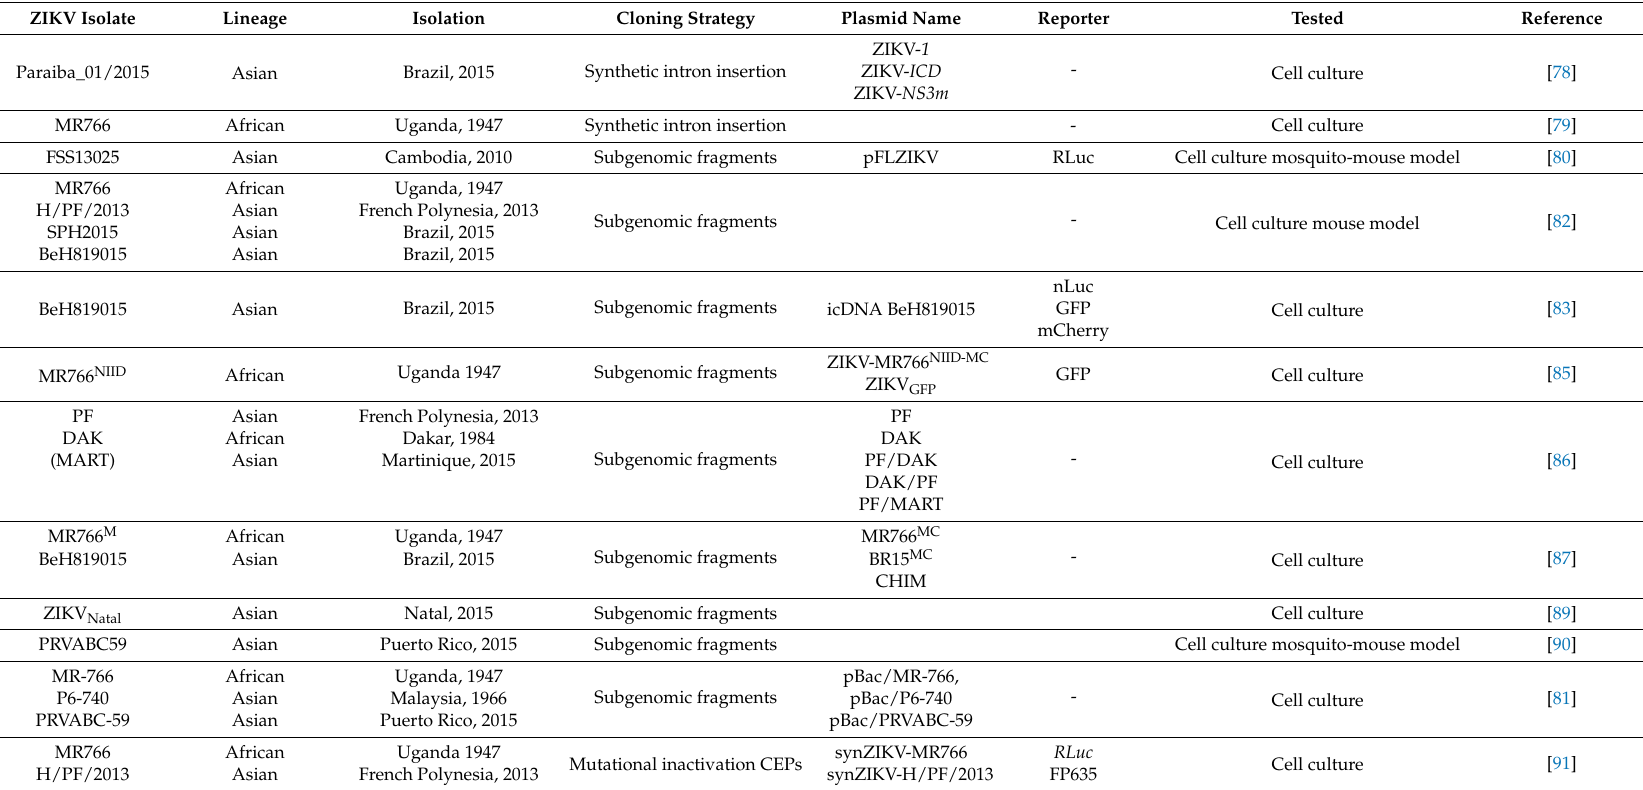
Table 1. Reverse genetic systems for ZIKV, full-length infectious